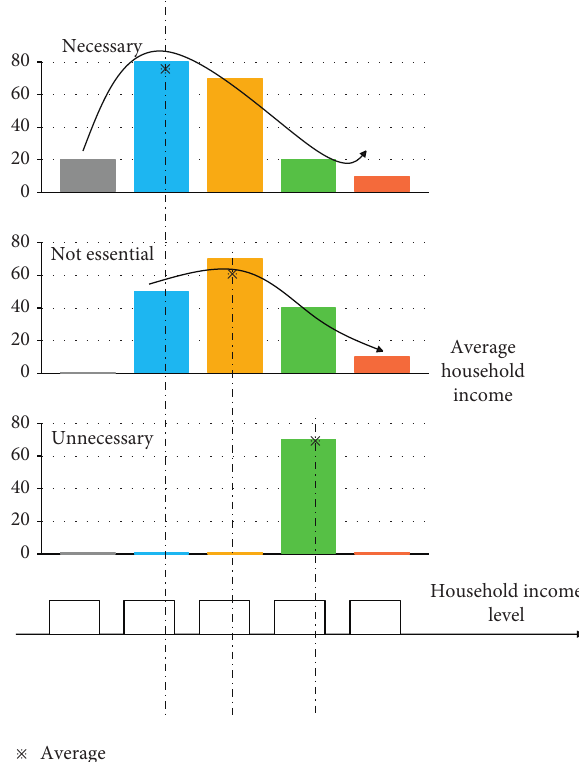
Figure 10: Average level of household income under different price attitudes.